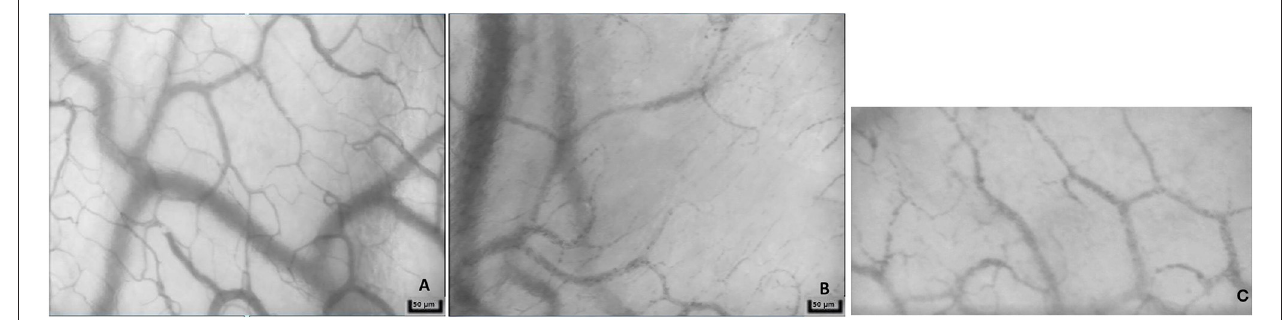
FIGURE 4 | Representative images from a sidestream dark-field microscopy device from a healthy dog (A) , dog in hemorrhagic shock (B) , and dog in septic shock (C) . Note the decreased density of capillaries in patients with shock.